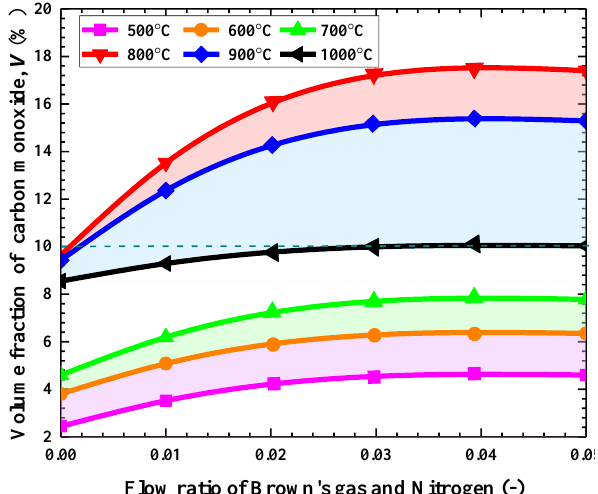
Figure 11. Relationship between the content of gas- phase tar and the flow volume ratio of Brown’s gas to nitrogen in pine wood pyrolysis. Figure 12. Relationship between the CO volume fraction and the flow volume ratio of Brown’s gas to nitrogen in pine wood pyrolysis.